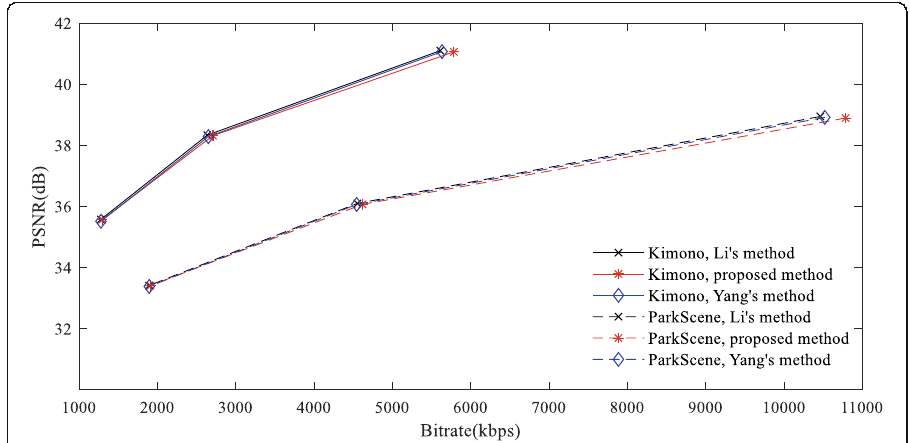
Fig. 9 Comparison of RD with Li ’ s method and Yang ’ s method for sequences Kimino and ParkScene